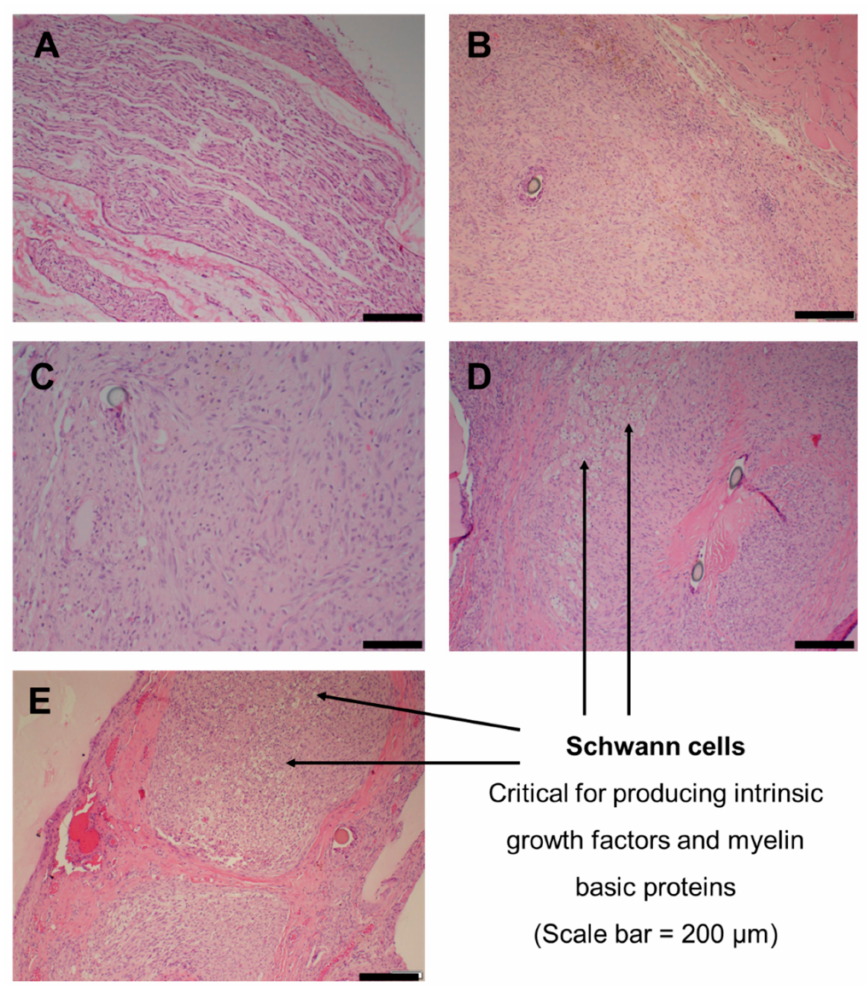
Figure 8. Histological images of regenerated sciatic nerve tissue in Groups ( A – E ) at 28